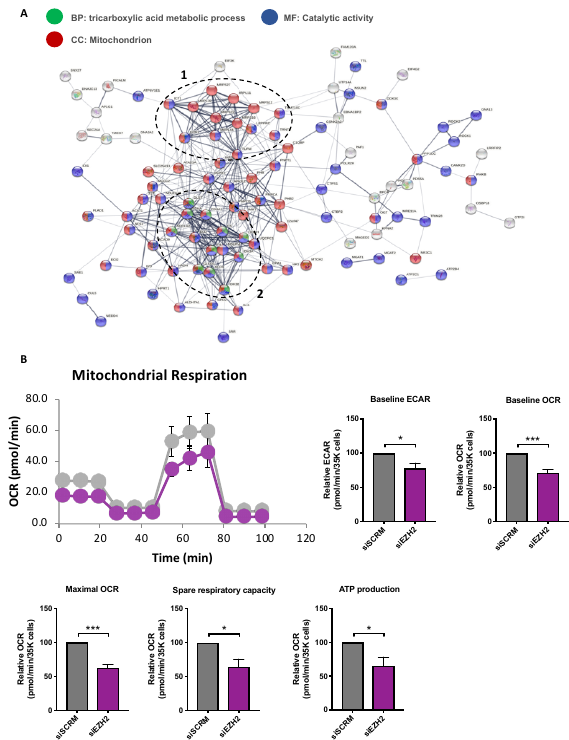
Figure 5. Impact of EZH2 suppression on PAH-PASMC bioenergetics. ( A ). Network analysis via STRING of the proteins found to be downregulated following EZH2 knockdown, revealing the presence of two major clusters of proteins associated with (1) mitochondrial gene expression and (2) glutamine-dependent biosynthetic pathway and tricarboxylic acid (TCA) cycle. Proteins belonging to the top enriched biological process (i.e. TCA cycle metabolism), molecular function (i.e. catalytic activity), and cellular component (i.e. mitochondrion) are colored in green, blue, and red, respectively. Proteins (nodes) with no predicted interactions were excluded. Thickness of the connecting lines correspond to the confidence level. Labels report protein names; ( B ) Assessment of mitochondrial function by the Seahorse XF96 analyzer in PAH-PASMCs exposed to siEZH2 or siSCRM for 48 h. The basal extracellular acidification rate (ECAR), basal oxygen consumption rate (OCR), maximal OCR, spare respiratory capacity, and ATP production were quantified following indicated injection of the specific stressors oligomycin (1 µ M), carbonyl cyanide-4-(trifluoromethoxy) phenylhydrazone (FCCP, 5 µ M), and rotenone (1 µ M). Seahorse data were normalized to the total cell numbers plated in each well. Experiments were performed in triplicate in three different PAH-PASMC cell lines. Data are presented as mean ± SEM; * p < 0.05 and *** p <